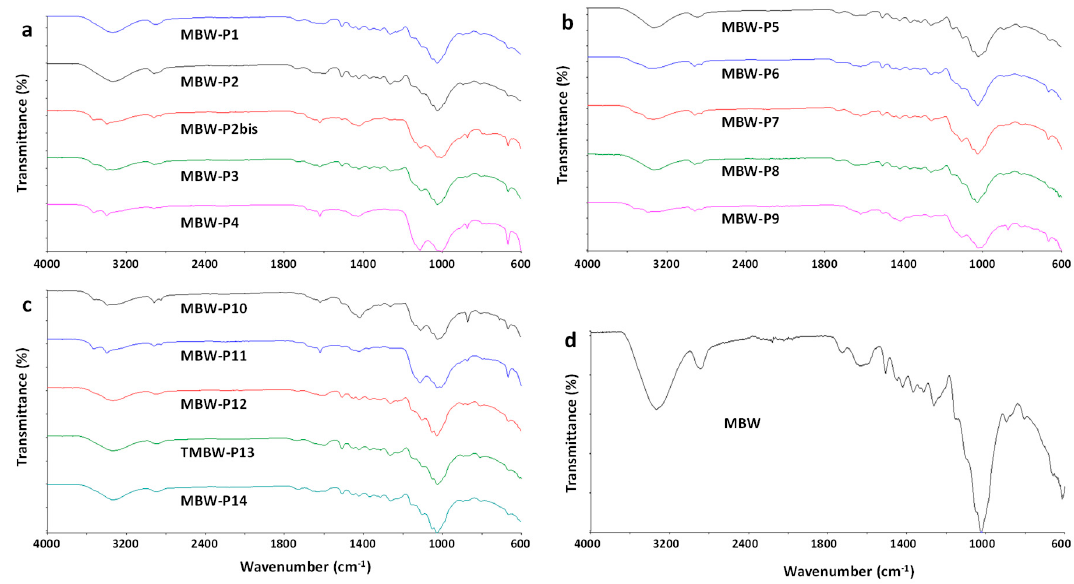
Figure 1. Attenuated total reflectance (ATR) ‐ FTIR spectra of MBW samples.